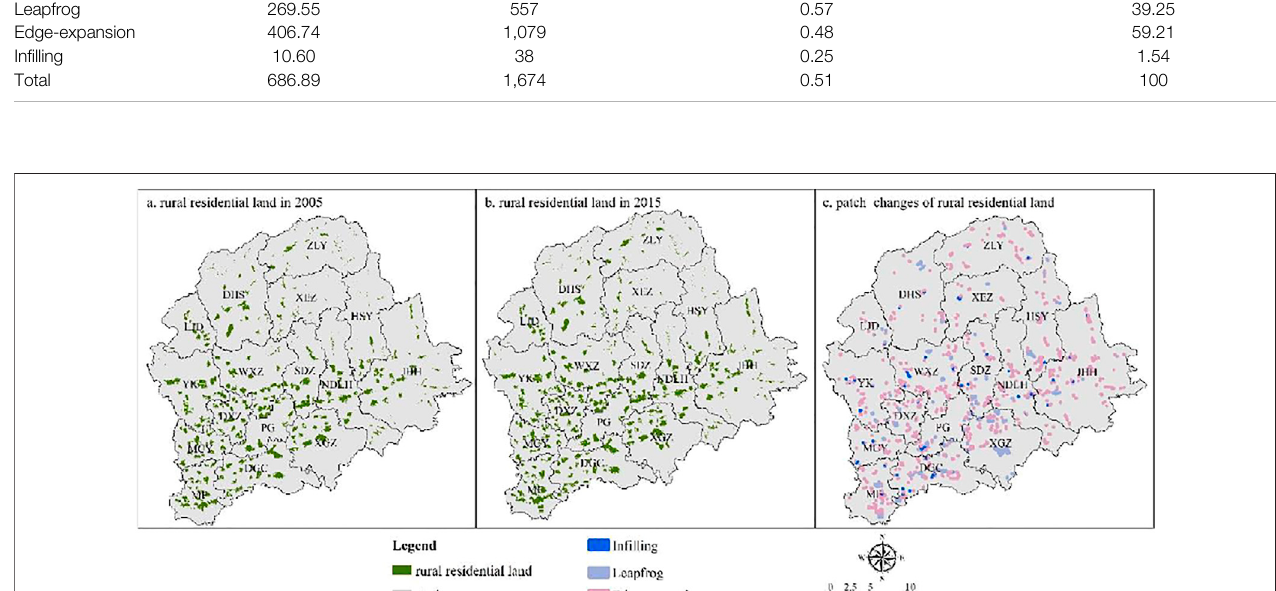
FIGURE 6 | Dynamic modes of rural residential land in Pinggu 2005 – 2015. the spatial distribution of rural residential land patches and its change processes in Pinggu [ (A) and (B) are the spatial distribution of rural residential land patches in 2005 and 2015; (C) is the spatial distribution of the three processes of change in rural residential land patches from 2005 to